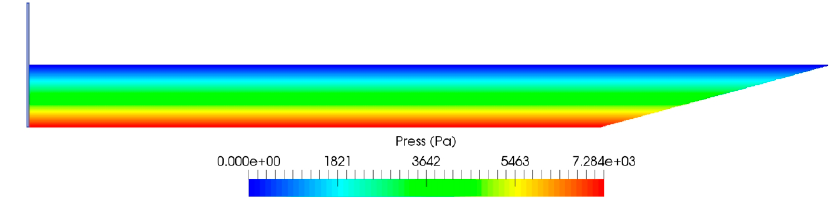
Figure 15. SPH result of hydrostatic pressure for d = 0.75 m.